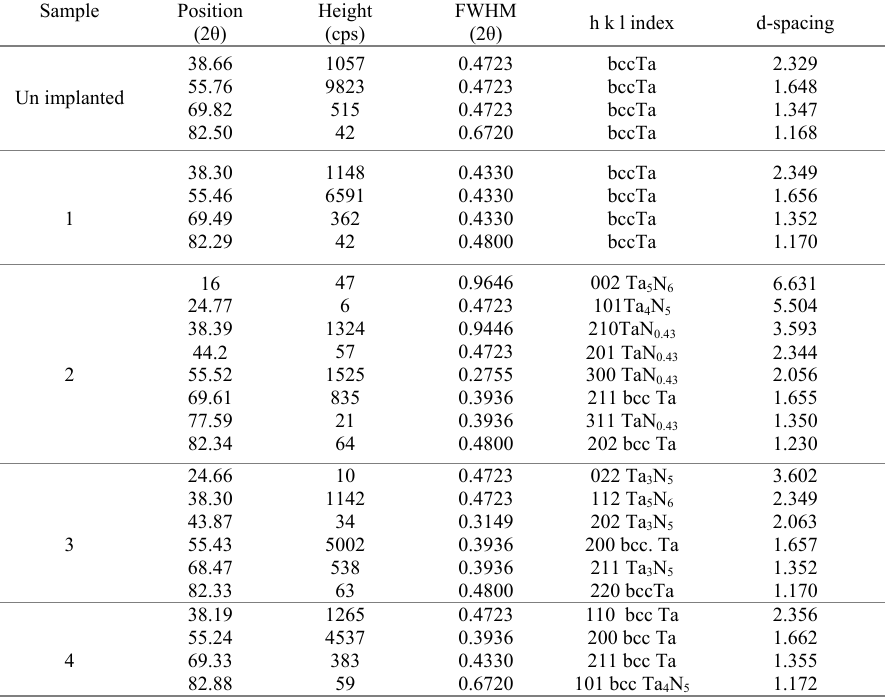
Table 2. Summary of XRD information and crystallite size of